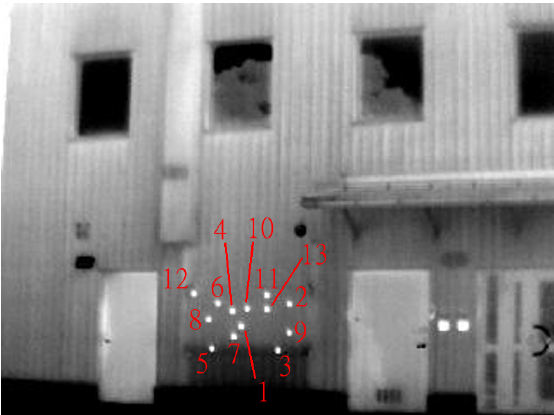
Figure 8. 13 heat spots (targets) prepared for this study and their identification numbers.